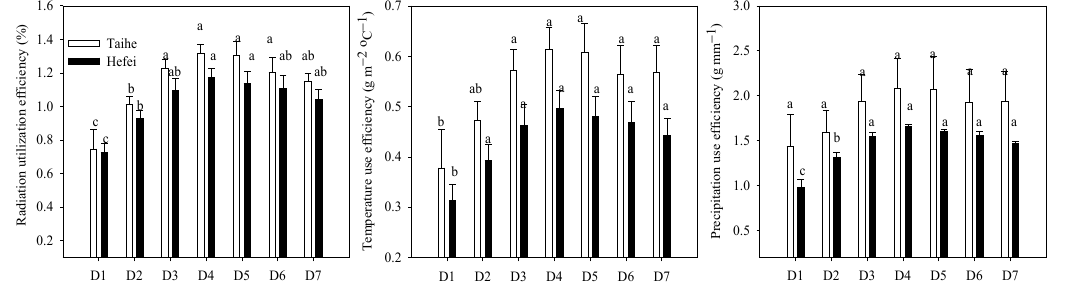
Figure 4. Climate resource utilization efficiency of different planting densities in two sites. Note: Different letters above the bars indicate significant differences among the different planting densities of a given site.